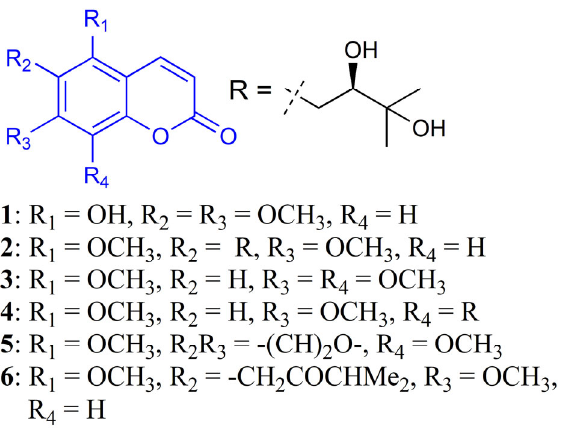
Figure 1. Chemical structures of compounds 1 – 6 separated from T. asiatica.